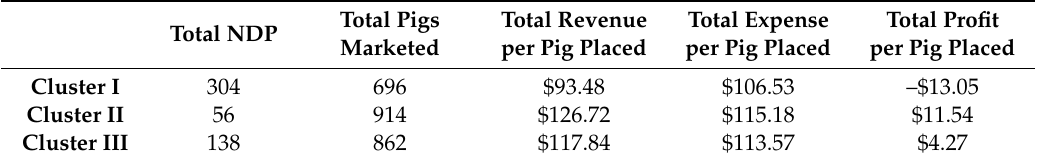
Table 9. Modelled expenses and net profit per pig appear for each cluster. Total NDP is the average total number of dead pigs for each of the clusters.